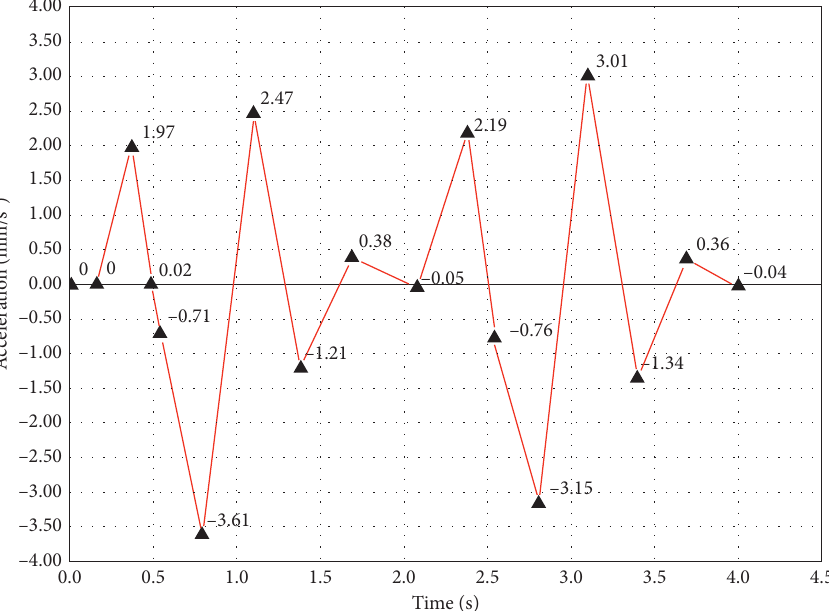
Figure 34: Measured acceleration at the top of the foundation pit cover near the